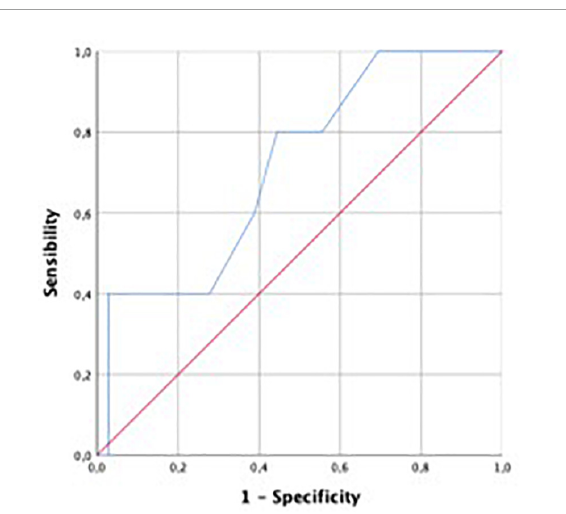
Receiver operating characteristic curve for predictive performance of LVGLS for LVSWI. LVGLS, left ventricular global longitudinal strain; LVSWI, left ventricular stroke work index.